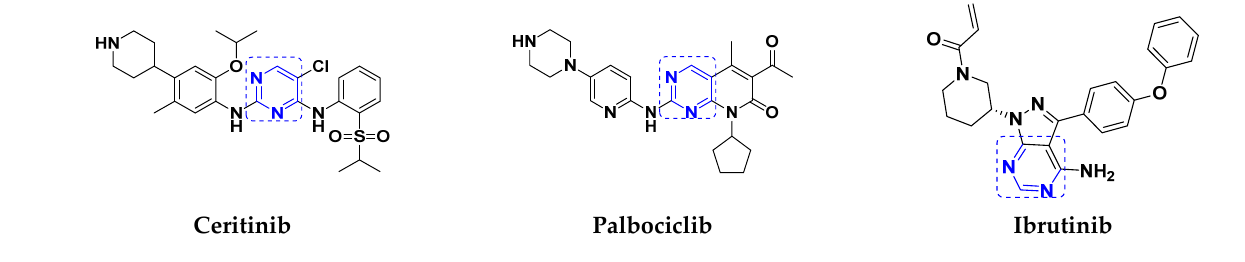
Figure 38. Pyrimidine based FDA approved drugs. Table 28. FDA approved pyrimidine based hybrids.